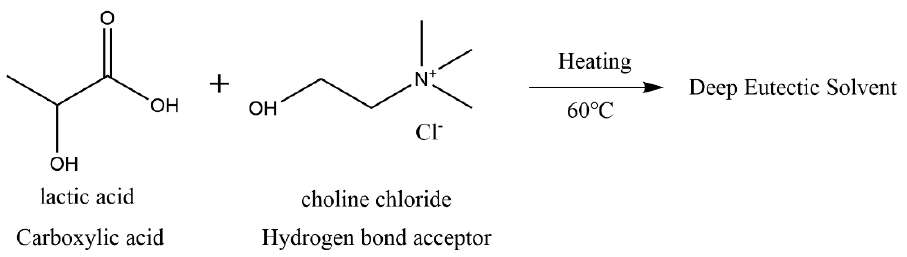
Figure 2. Choline chloride reacted with hydrogen bond acceptor to produce deep eutectic solvents .